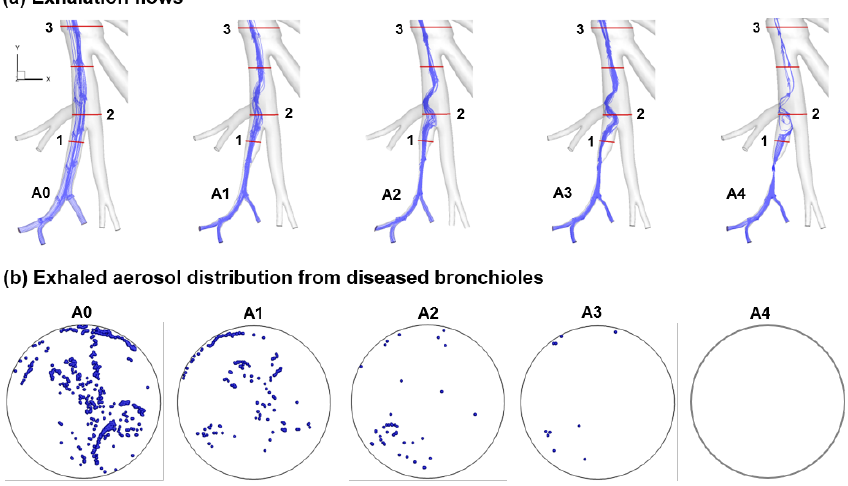
Figure 11. Airflow and aerosol dynamics in the test case 3: ( a ) comparison of streamlines near the constricted bronchioles at G7 among five stages and ( b ) exhaled particle distribution for particles originated only from the disease-affected bronchioles at varying stages.